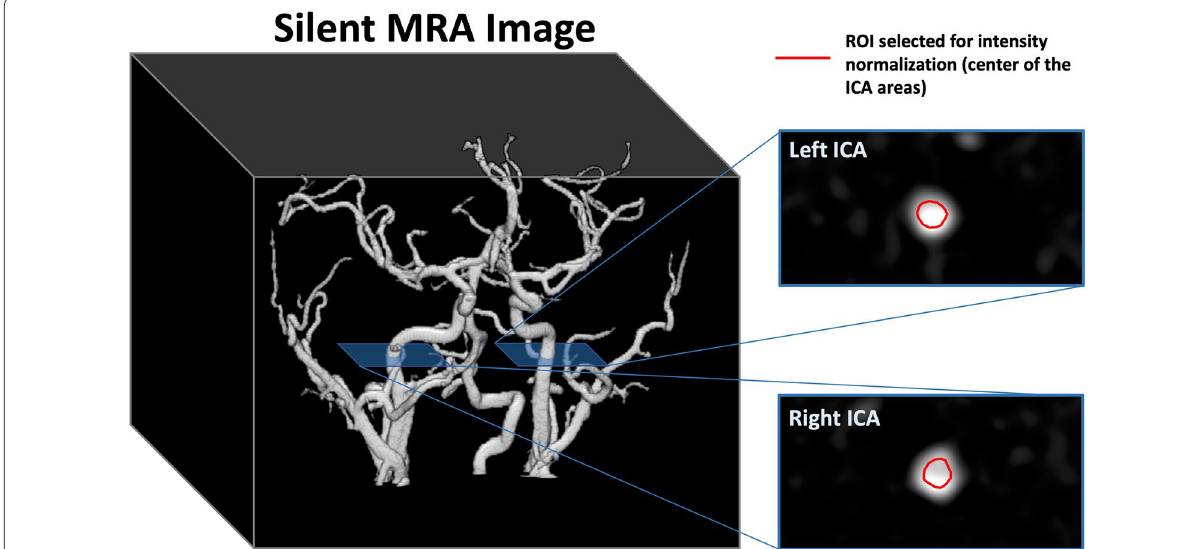
Fig. 1 Locations of selected ROIs (marked with red lines) based on bilateral cervical segments of internal carotid arteries (ICA) for intensity normalization. The magnitudes of the individual Silent MRA data were divided by the average intensity value of the two selected ROIs for the following group‑level